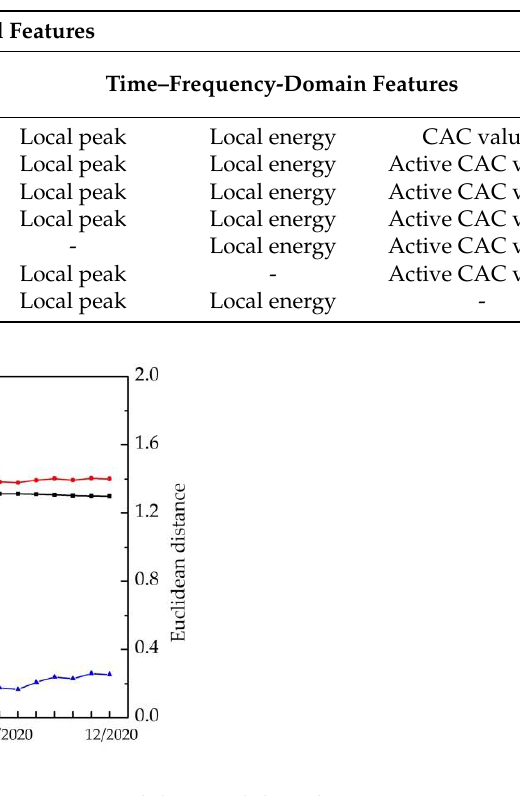
Table 8. Fusion schemes.